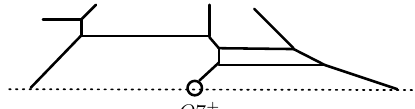
Figure 13. (a) A 5-brane web for SU(3) 3 +1 Sym which has a − 1 curve on the left hand side of an 2 O 7 + -plane. (b) A flop transition and allocating a D5-brane from the right to the left. (c) Decoupling the ‘instantonic’ hypermultiplet, which leads to a 5-brane configuration for a non-Lagrangian theory, P 2 ∪ F 3 + “1 Sym ”.